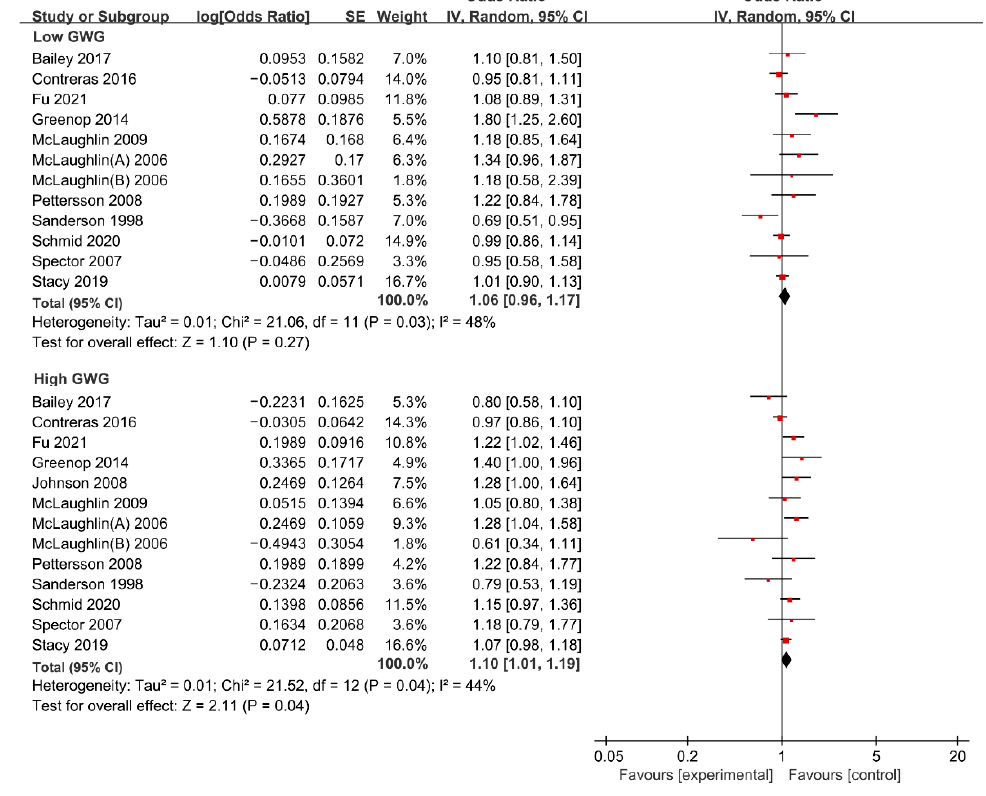
Risk estimates between maternal low GWG and risk of specific cancers including leu- kemia, brain cancer, breast cancer, testicular germ-cell cancer, hepatoblastoma, and neu-